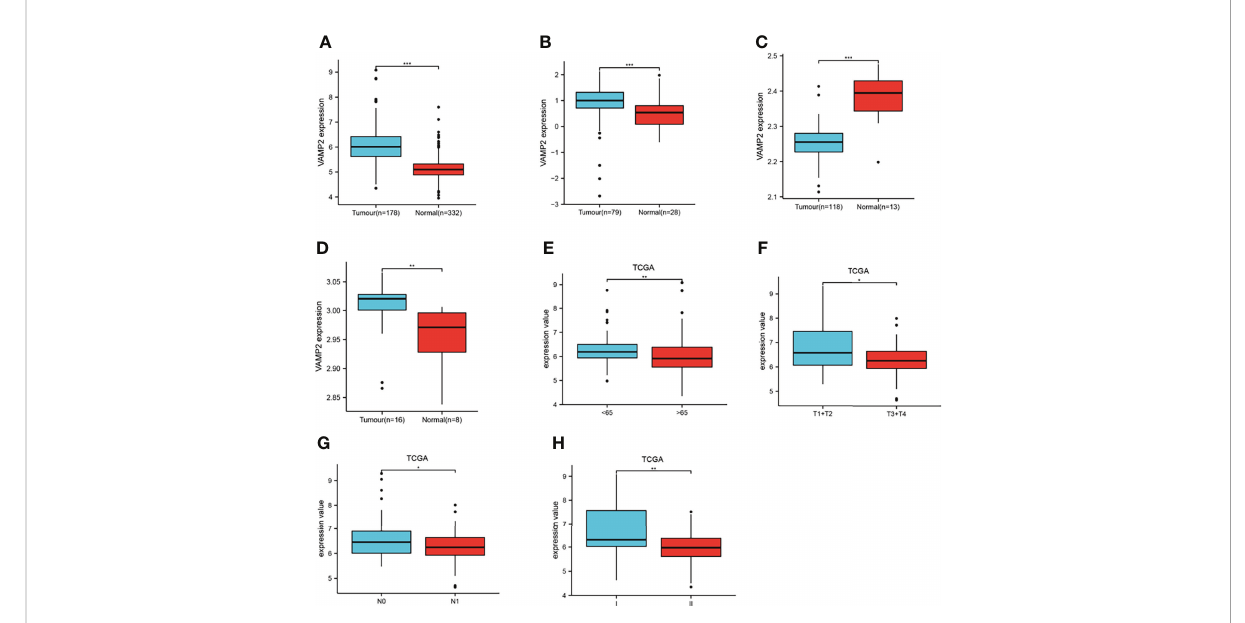
FIGURE 6 Expression of VAMP2. (A) : TCGA dataset as the training set, (B – D) : GSE11838, GSE62165, and GSE15932 as the validation set for analyzing the expression of VAMP2 in cancer versus paracancer and observing the expression differences between age, T stage, N stage, and pTNM stage (E – H) . *P<0.05, **P<0.01, ***P<0.001.